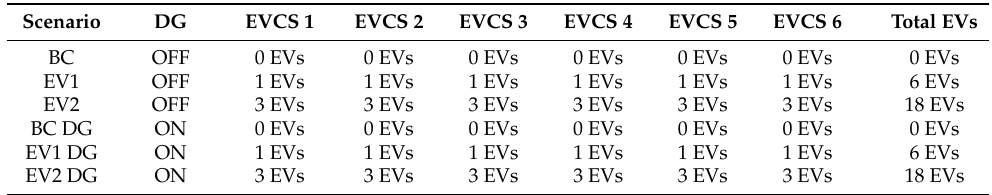
Table 3. Scenarios under